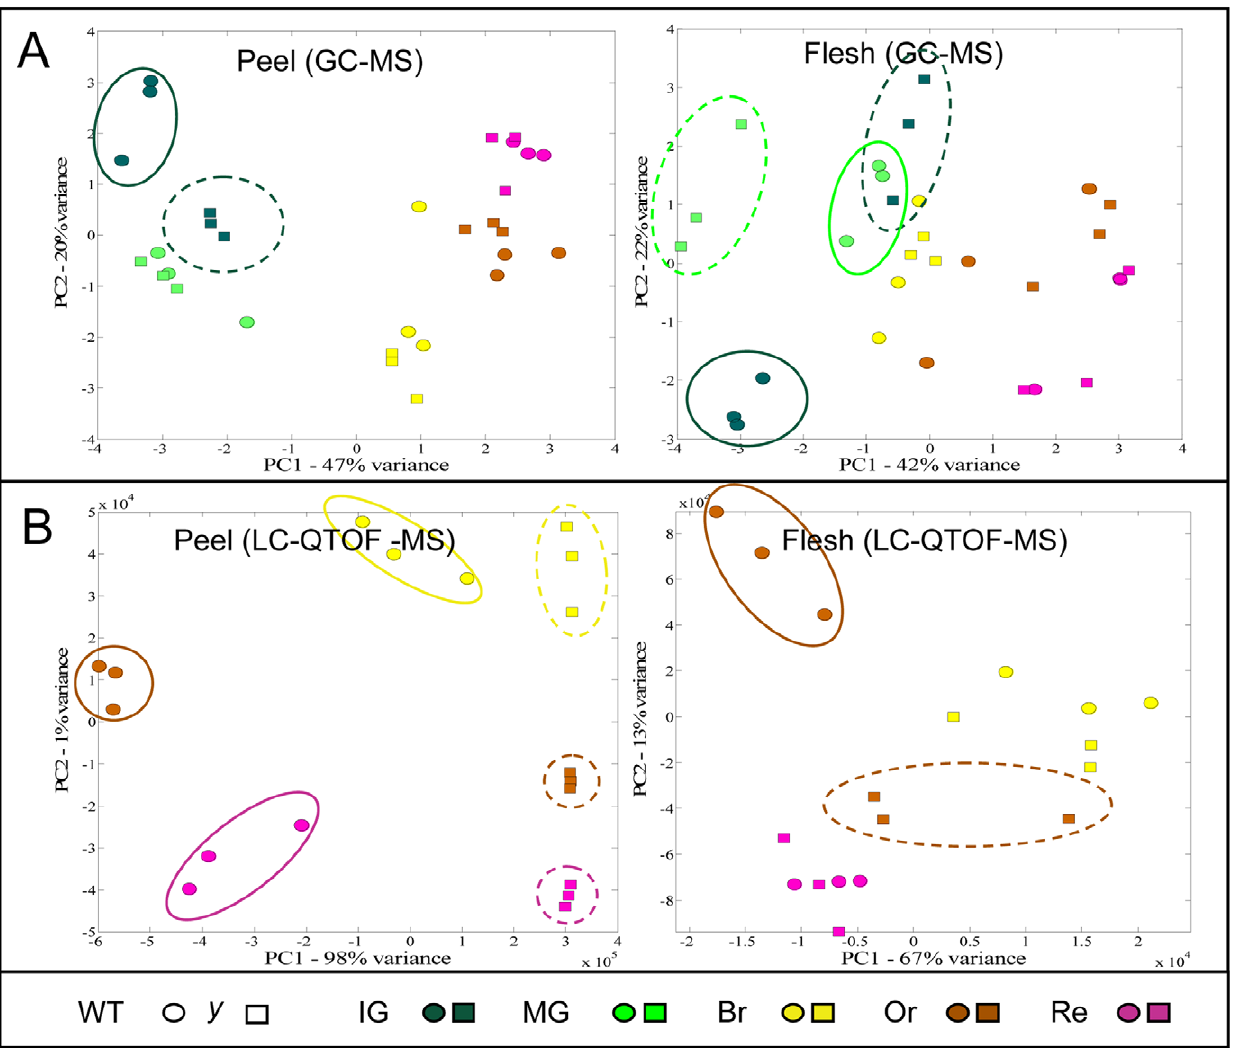
Figure 3. Differences between metabolic profiles of wt and y mutant peel and flesh tissues detected by principal component analysis (PCA) of GC-MS and LC-QTOF-MS data sets. (A) PCA of metabolic profiles obtained by GC-MS analysis, with samples of wt and y peel and flesh tissues at five stages of fruit development (n=3). (B) PCA of metabolic profiles obtained by UPLC-QTOF-MS analysis, with samples of wt and y peel and flesh tissues in the last three stages of fruit development (n=3). Distinct metabolic profiles that correspond to particular stages of y and wt fruit development are encircled in (A,B).